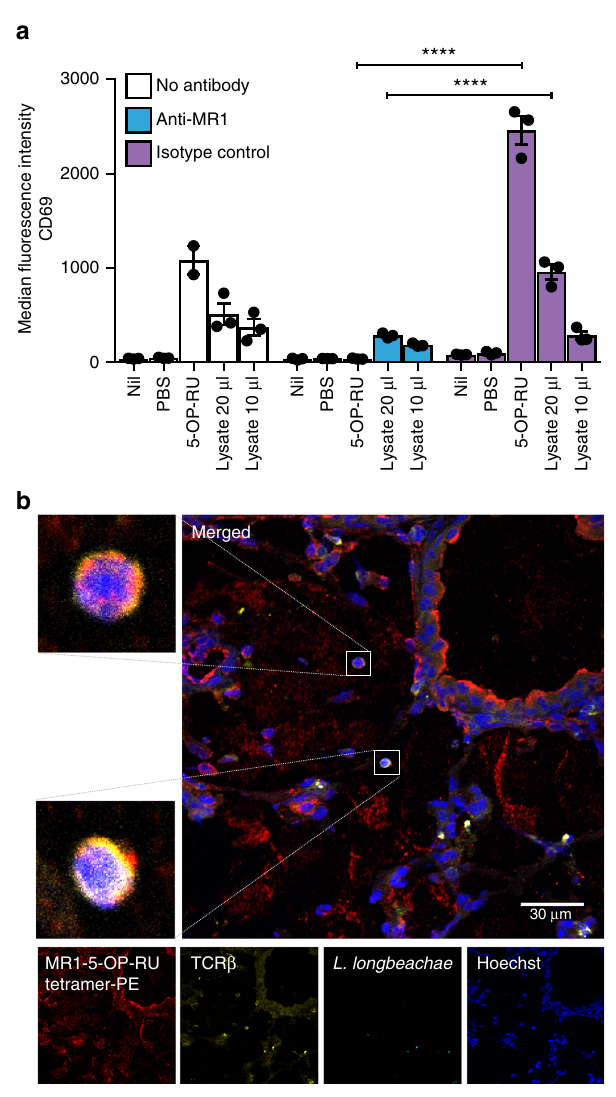
Fig. 2 Legionella activates tetramer + mouse MAIT cells in vitro via MR1. a Splenocytes (2×10 5 ) from V α 19iC α − / − MR1 + .Ly5.1 mice were prepared and co-cultured with iBMDM.MR1 cells (10 5 ) overnight with or without lysate (20 μ l or 10 μ l) of L. longbeachae . 5-OP-RU was used as a positive control at a fi nal concentration of 1nM. Anti-mouse MR1 monclonal antibody 8F2 or its IgG1 isotype control (in-house) were added at 20 μ gml − 1 to examine MR1-speci fi c Ag presentation. CD69 upregulation (MFI) on MAIT cells was measured by fl ow cytometry for MAIT cell activation after staining together with other T-cell antibodies and MR1-5-OP-RU tetramers. Two way ANOVA with **** P < 0.0001. b Immuno fl uorescence micrographs of murine lungs showing TCR β + , MR1-5-OP-RU-tetramer + MAIT cells (white boxes) in C57BL/6 mice infected intranasally with 2×10 4 stained with control tetramer MR1-6-FP are presented in Supplementary Fig. 3. Red, MR1-5-OP-RU tetramer; yellow, TCR β ; cyan, L. longbeachae ;